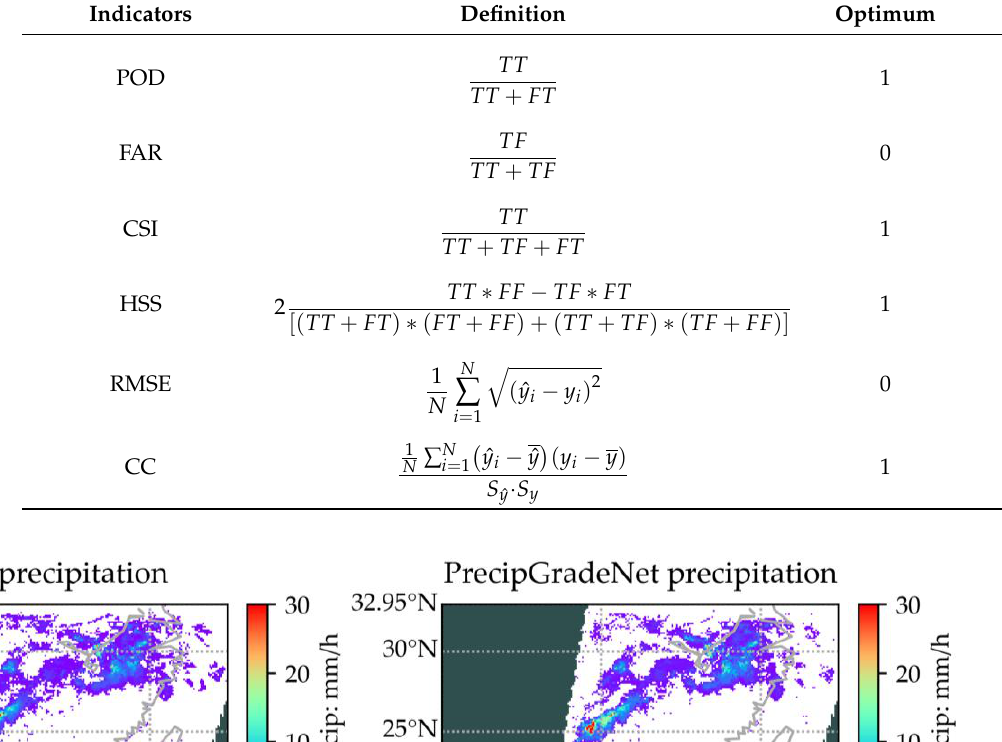
Table 6. Description of the indicators. TT represents the pixel number of true positive, TF represents the pixel number of false positive, FF represents the pixel number of true negative, FT represents the pixel number of detection failure; y i is the truth, and ˆ y i is the estimation. “Optimum” indicates the best value for the indicators.